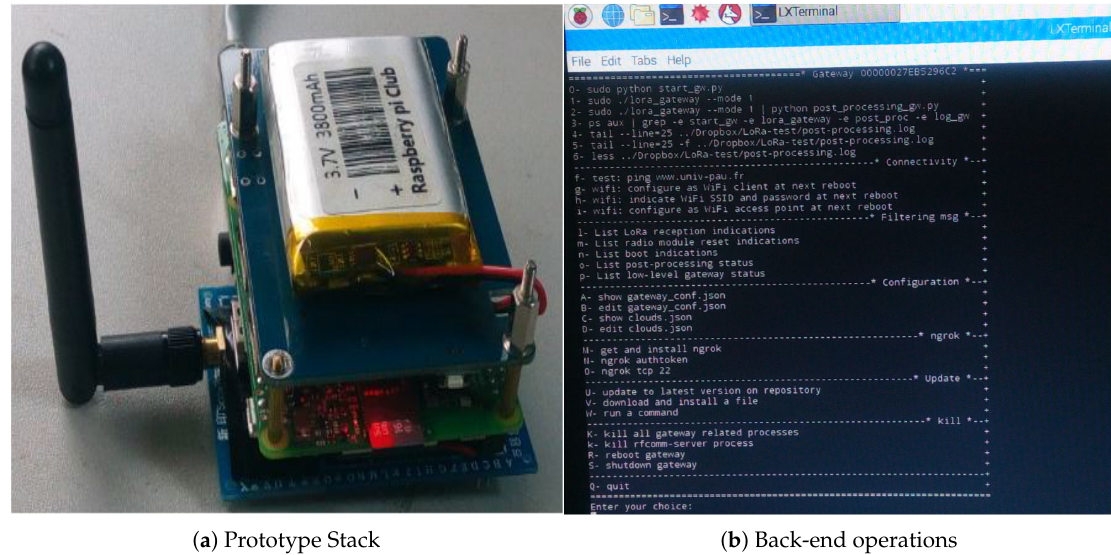
Figure 18. Side view of the prototype stack and back-end operations.